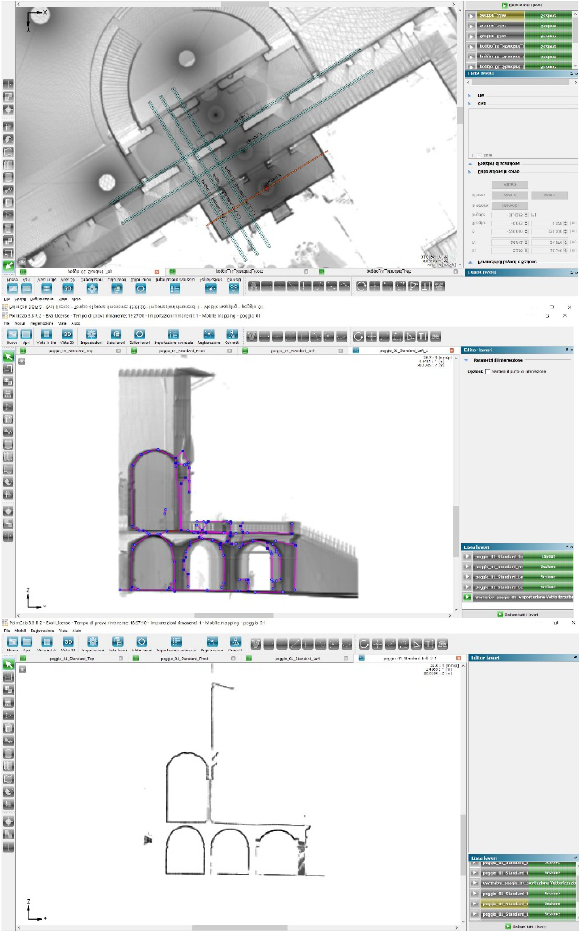
Figure 4: a part of the workflow in Point-cab for revit: section positioning; section outlined; lines